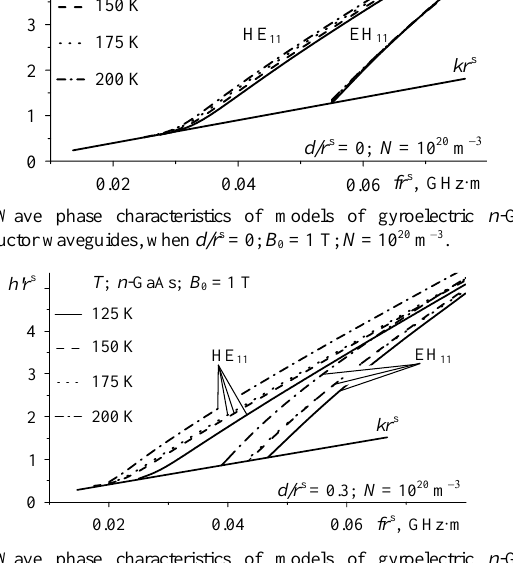
5·10 18 m –3 and 10 20 m –3